Question: According to this chart, does the measure grow or shrink?
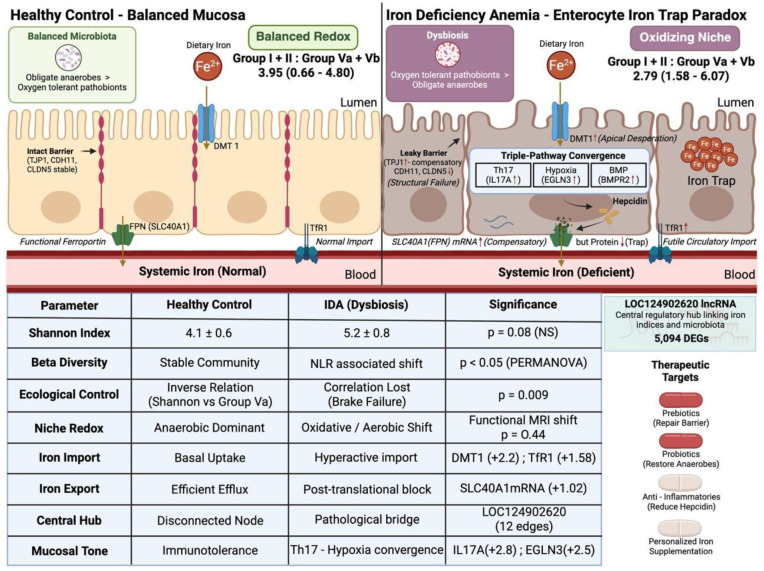
Answer: increasing